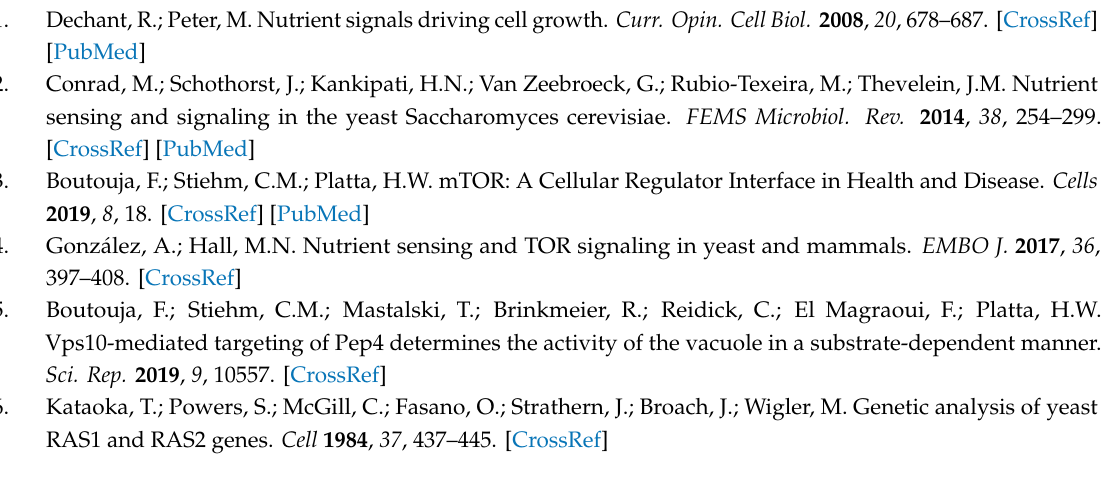
Supplementary Figure S1: Uncropped western